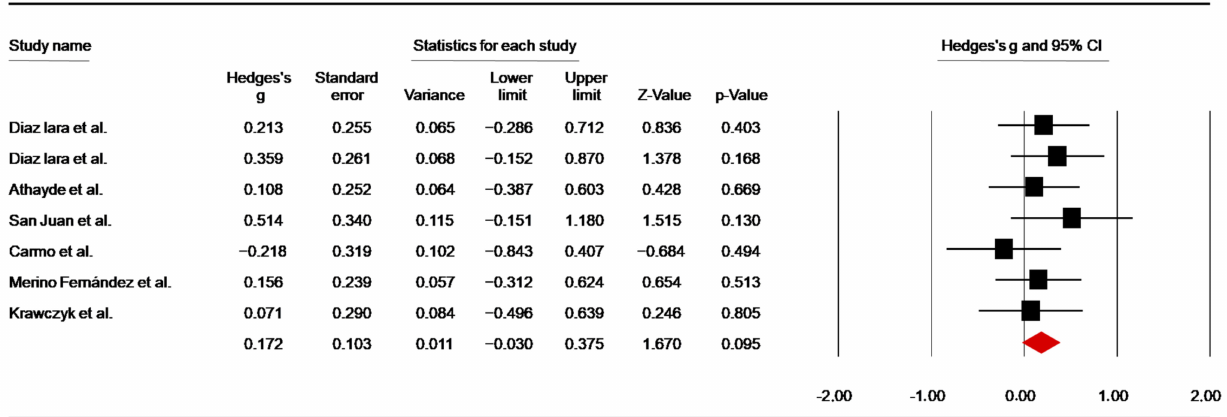
Figure 2. Forest plot of the effect of caffeine intake on CMJ [46–49,59,60,64]. Handgrip Strength